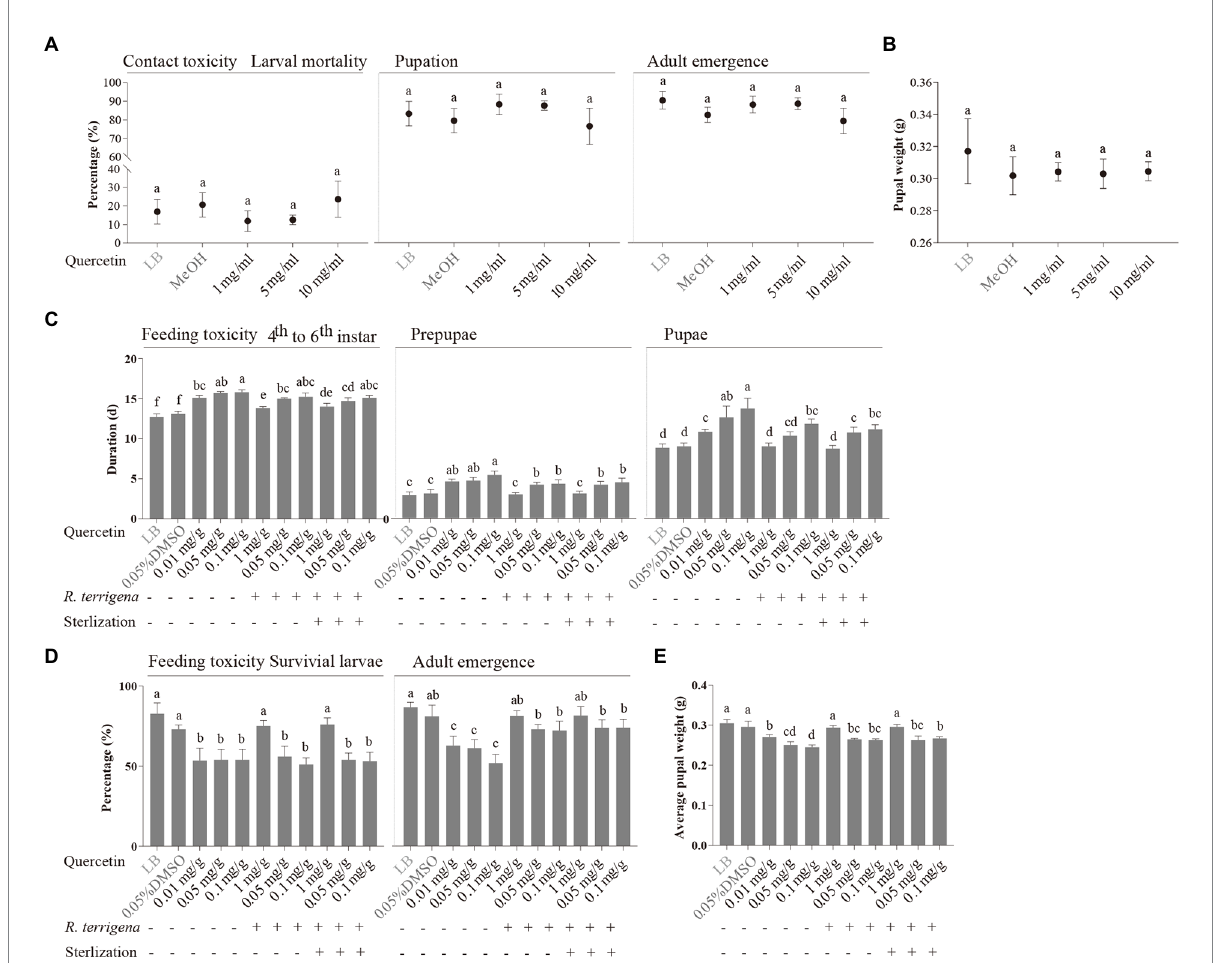
FIGURE 4 Toxicity of quercetin against S. litura . Effects of quercetin on larval mortality, pupation rate, adult emergence rate (A) and average pupal weight (B) of S. litura using filter paper diffusion assay, developmental durations of the different developmental stages of S. litura (C) , percentages of survival larvae and adult emergence (D) , and average pupal weight (E) of S. litura reared on the artificial diets containing 0.01, 0.05 or 0.1 mg/g quercetin which was cocultured with or without R. terrigena for 48